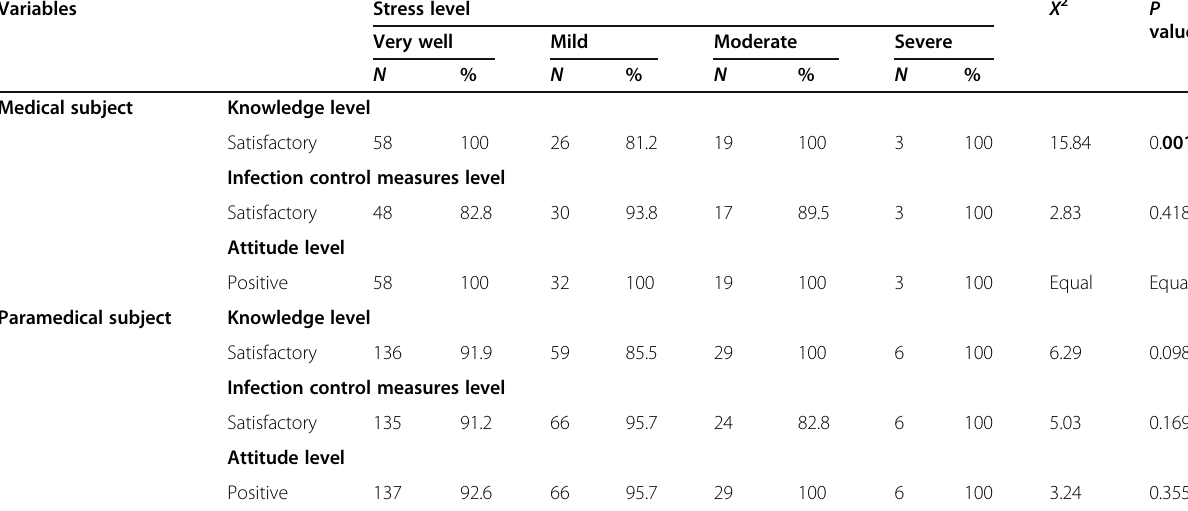
Table 3 Correlation between knowledge level, infection control measures, attitude level, and COVID-19 psychological stress levels of studied staff (medical and paramedical) ( n = 364) Variables Stress level X